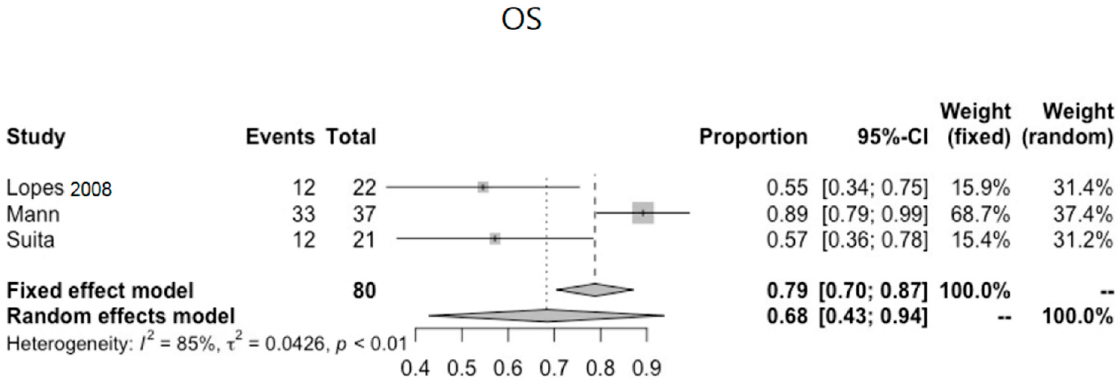
Figure 6. Pooled OS data for sacrococcygeal GCTs.